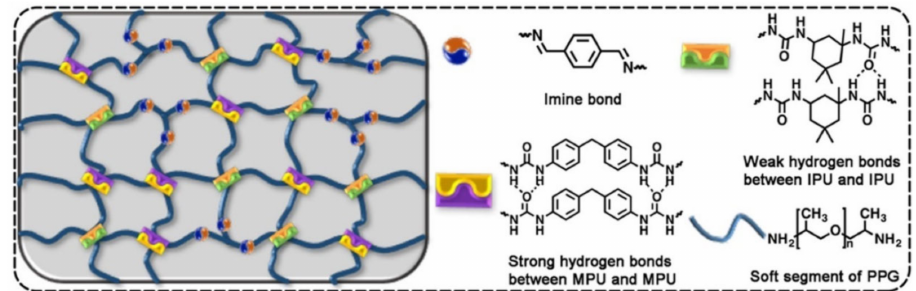
Figure 34. Block diagram of the PU network, which contains both dynamic imine bonds and hierarchical H-bonds. Reprinted with permission from [186]. Copyright (2020) American Chemical Society.